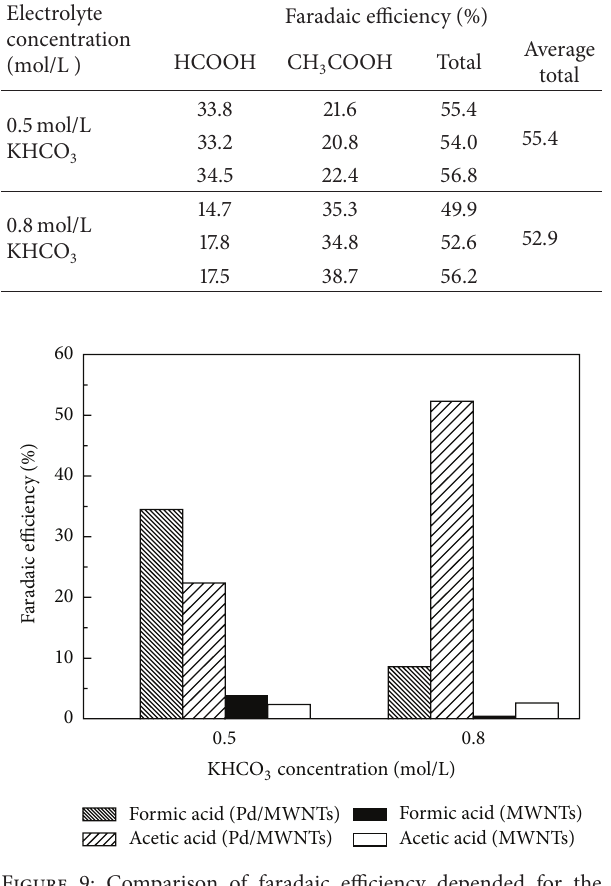
Figure 9: Comparison of faradaic efficiency depended for the products in 0.5 mol/L KHCO 3 (4V, 20min) and 0.8 mol/L KHCO 3 (4V, 5 min) by electrochemical reduction of CO 2